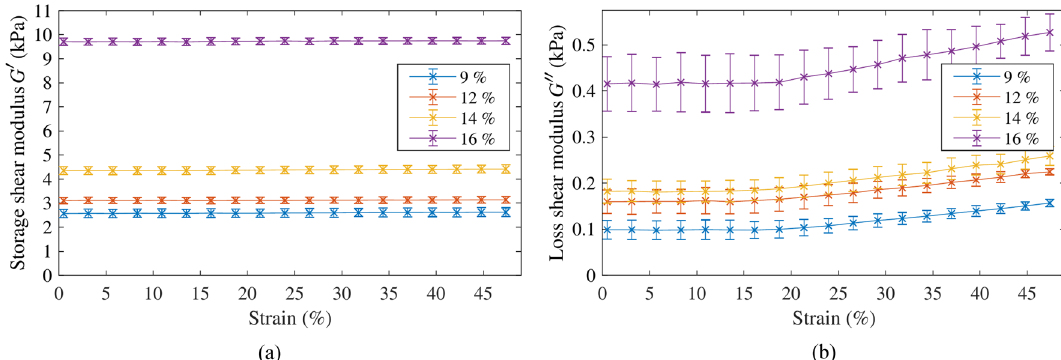
Figure 7. ( a ) Storage shear modulus and ( b ) loss shear modulus, as a function of the strain for the different gelatine